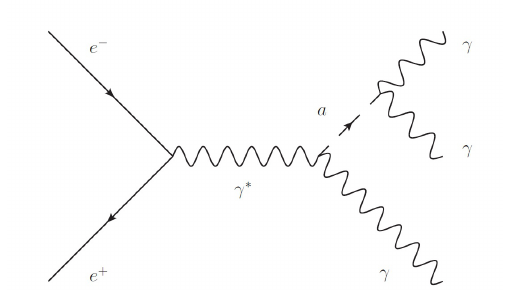
Figure 6. Feynman diagram for the process e + e − → γ a , with a → γ γ .